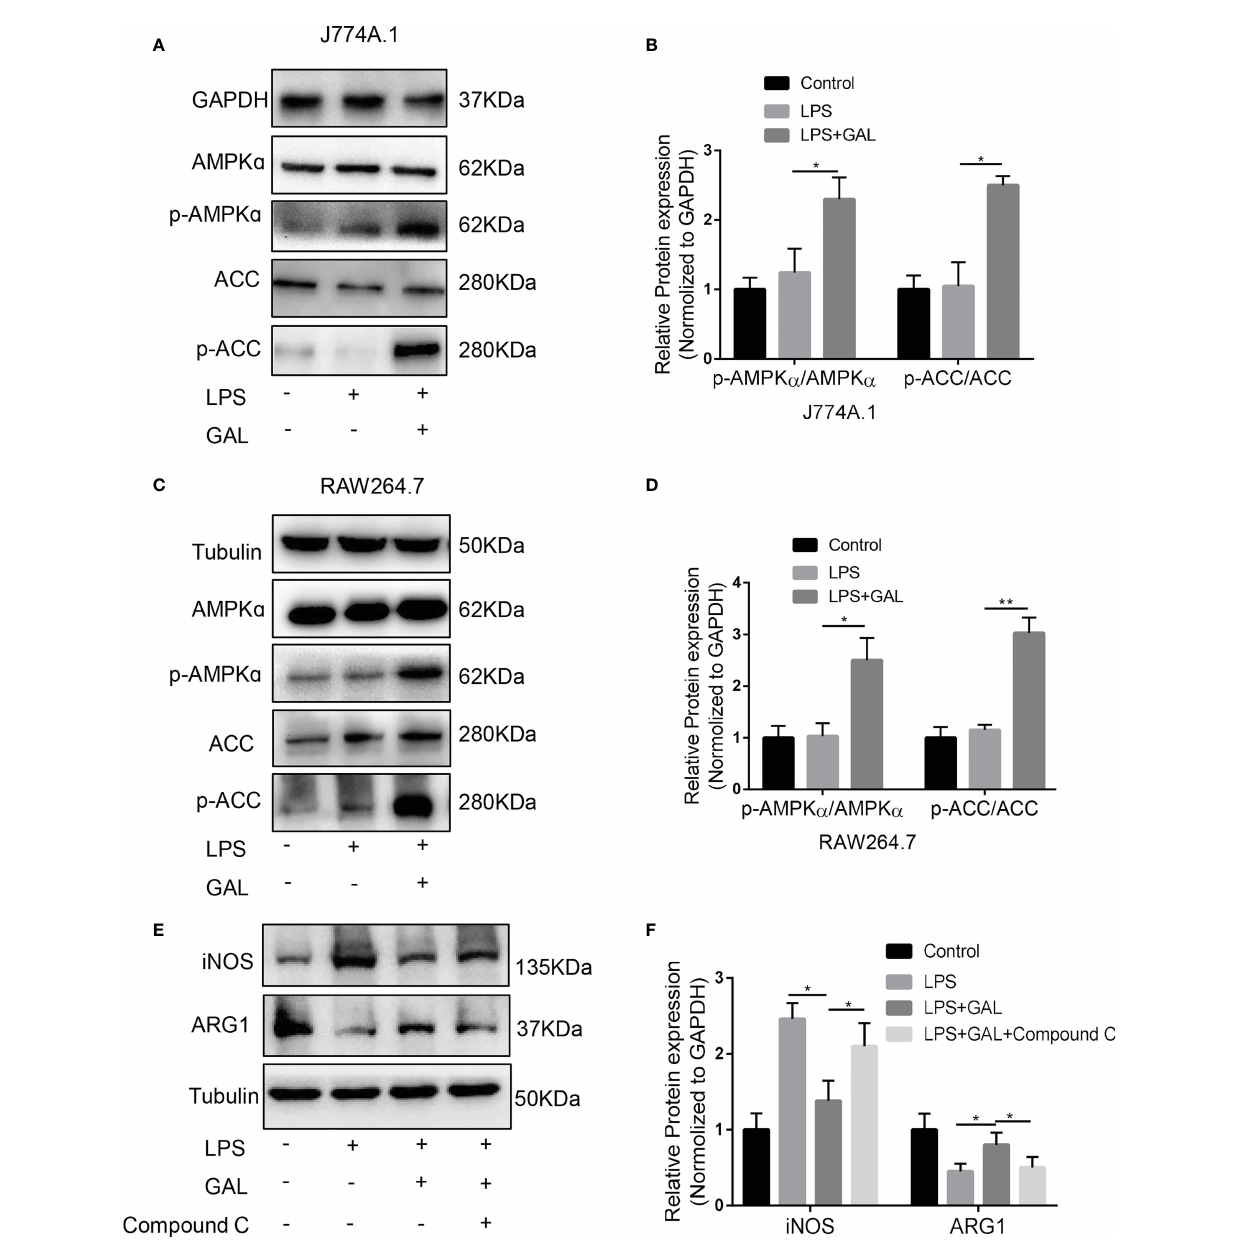
FIGURE 6 AMPK/ACC signaling mediates the effect of galanin on shifting in fl ammatory phenotype of macrophages. (A) The protein levels of AMPK, p-AMPK, ACC, p-ACC expressions in response to galanin in J774A.1 macrophages were measured by western blot. (B) Quanti fi cation of (A) *, p < 0.05. (C) The protein levels of AMPK, p-AMPK, ACC, p-ACC expressions in response to galanin in RAW264.7 macrophages were measured by western blot. (D) Quanti fi cation of (C) *, p < 0.05. **, p < 0.01. (E) J774A.1 macrophages were pretreated with Compound (C) iNOS and ARG1 expressions were detected by western blot. (F) Quanti fi cation of (E) *, p < 0.05. AMPK: AMP-activated protein kinase. p-AMPK, Phosphorylated AMP-activated protein kinase; ACC, Acetyl-CoA carboxylase; p-ACC, Phosphorylated acetyl-CoA carboxylase; GAL,